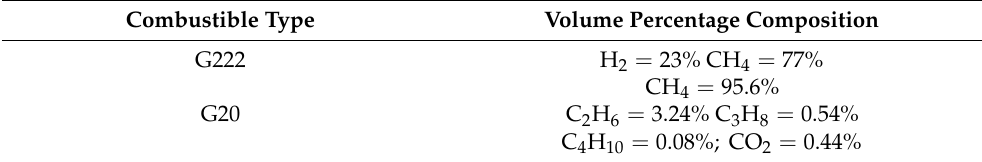
Table 2. Gaseous combustible